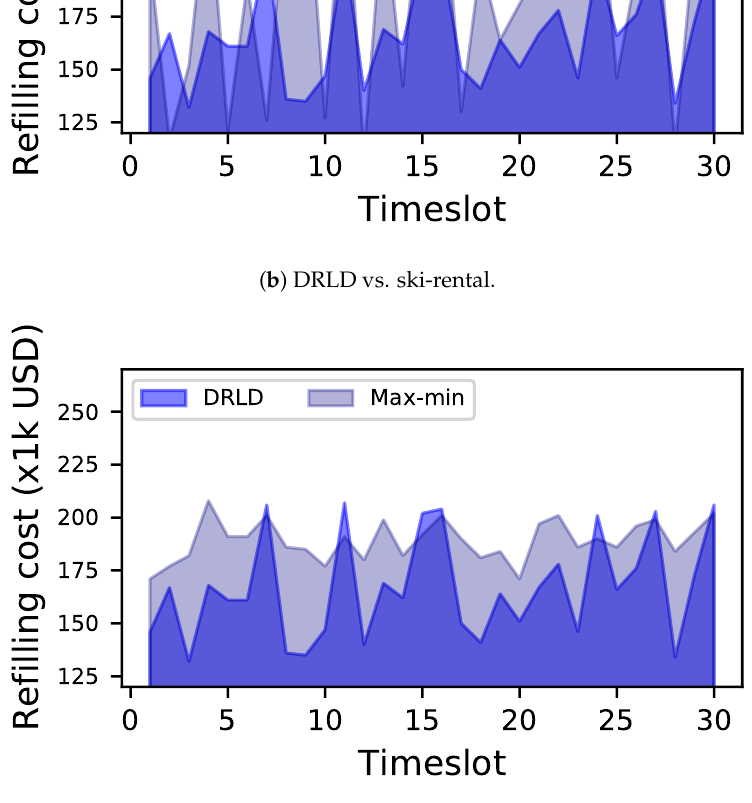
Figure 5. Refilling cost